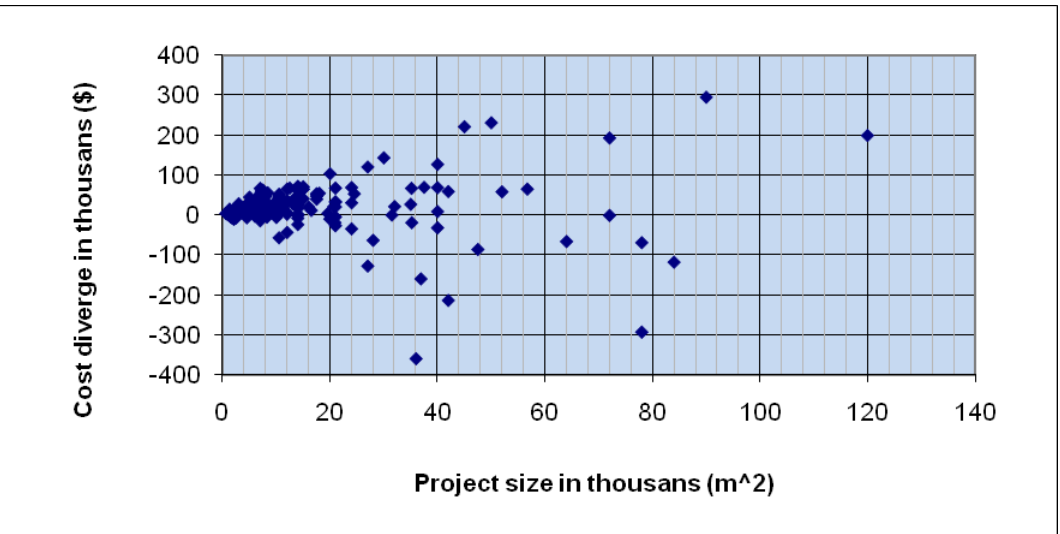
Figure 14 Cost deviation ($) vs. project size in road construction